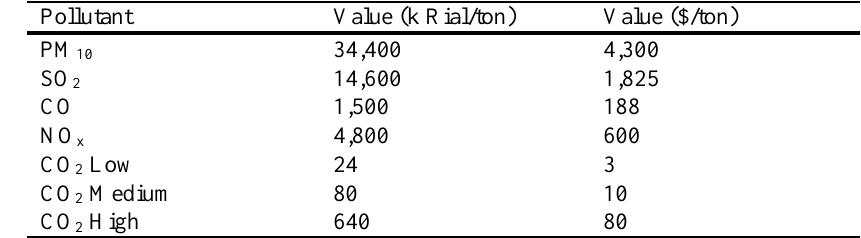
Table 1. Benefit values proposed for Iran